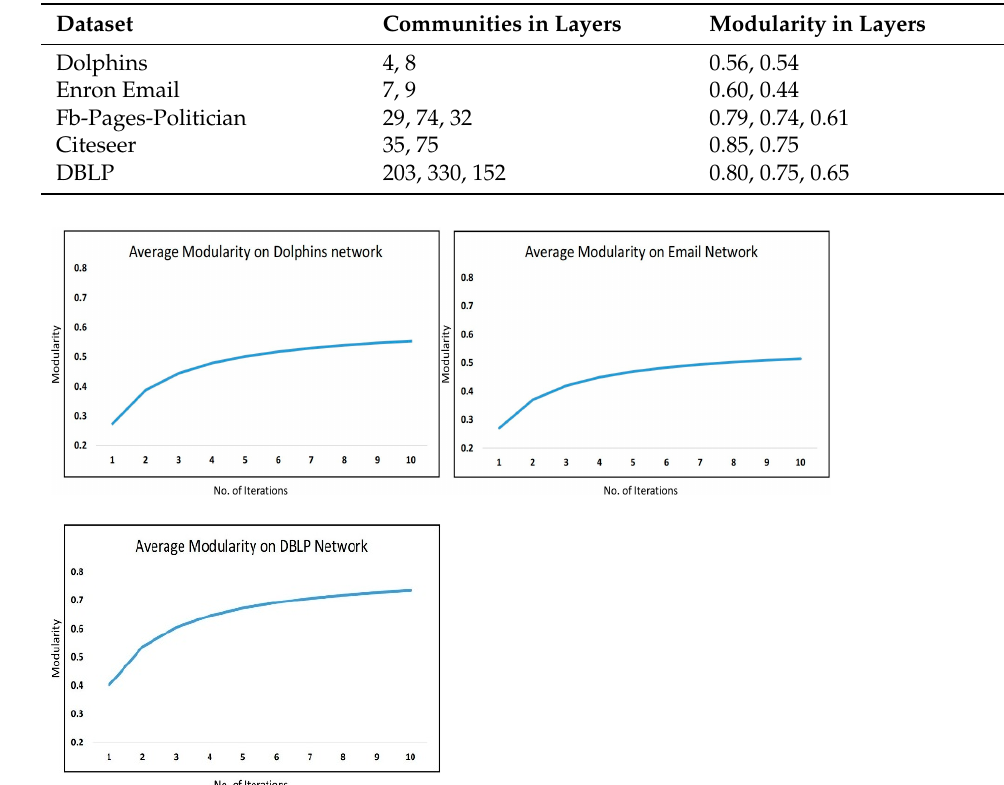
Table 2. Statistics of the detected layers in different graphs with HCD method.